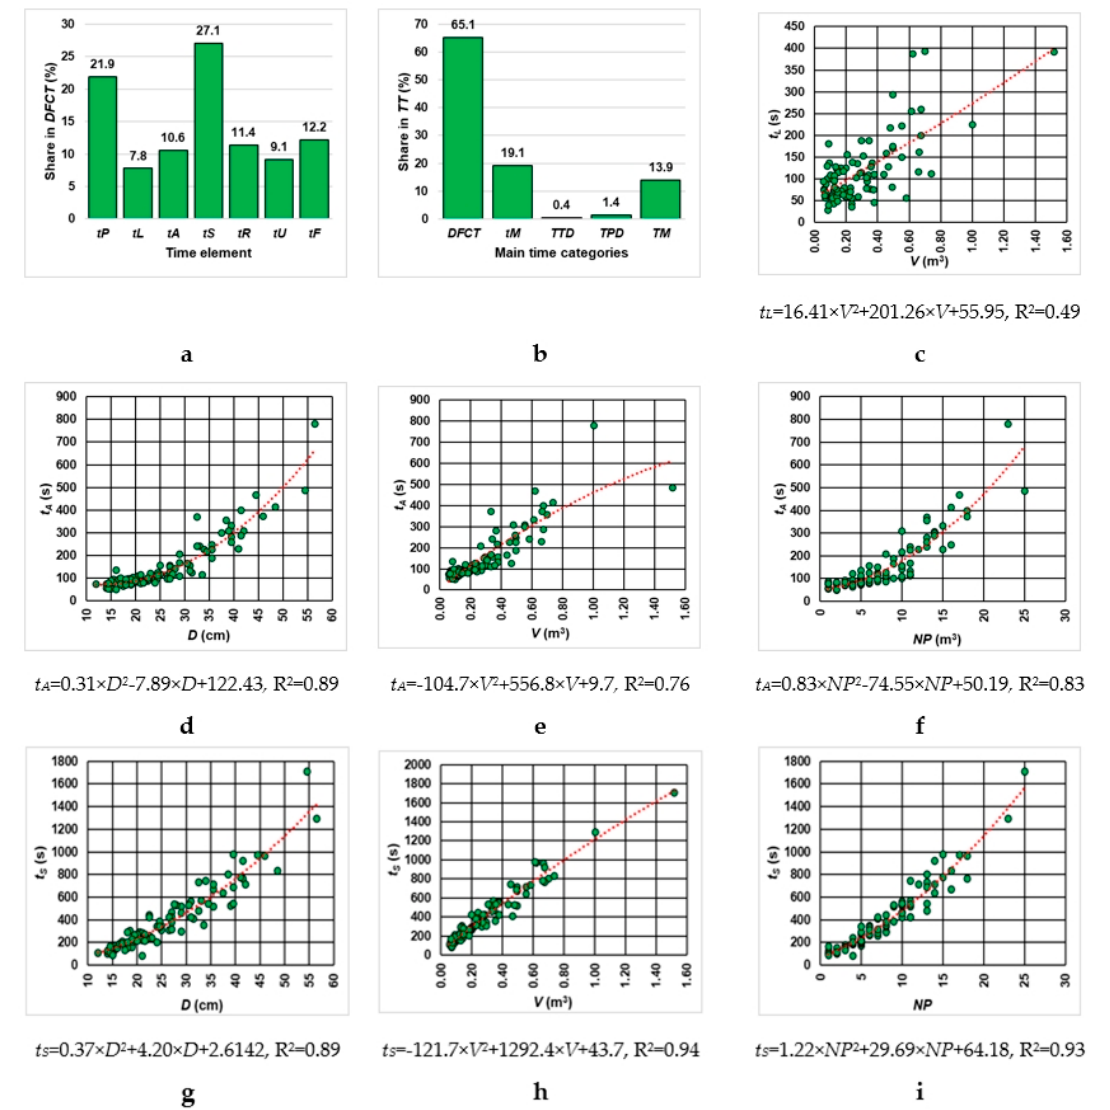
Figure 3. Time consumption models. Legend: ( a , b )—shares on time consumption categories; ( c )—time consumption models for log loading ( t L ); ( d – f )—time consumption models for blade adjustment ( t A ); ( g – i )—time consumption models for sawing ( t S ); D —average log diameter, V —log volume, NP —number of produced pieces.